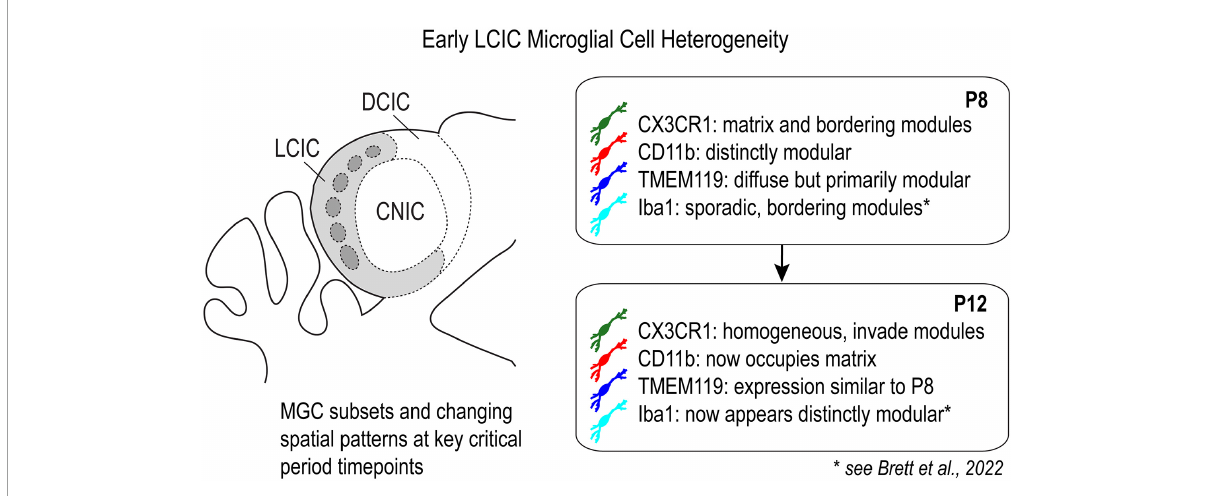
FIGURE11 Schematic highlighting differential expression of established microglial cell (MGC) markers in the lateral cortex of the inferior colliculus (LCIC) at key critical period